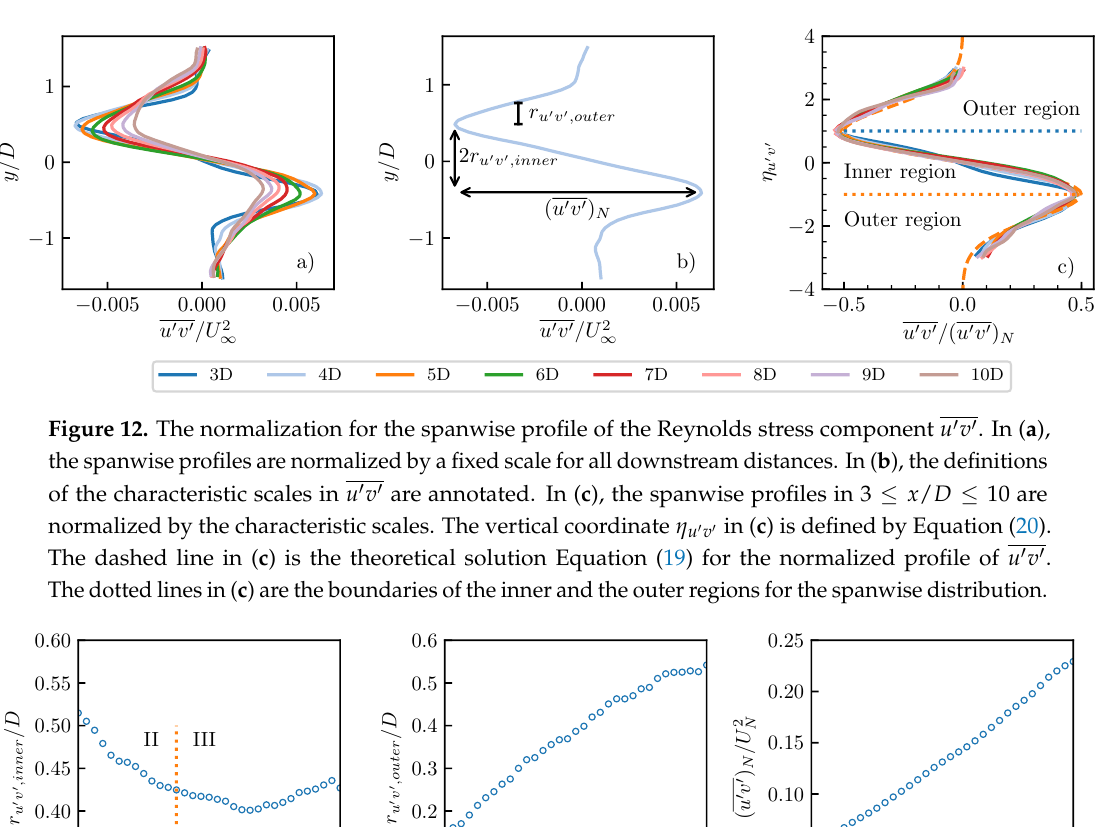
Figure 13. The streamwise development of the characteristic scales of the Reynolds stress component u (cid:48) v (cid:48) . The characteristic widths of the inner region and outer region are shown in ( a , b ), respectively, where the dotted line is the boundary of the stage II and III of the wake development. In ( c ), the characteristic Reynolds stress ( u (cid:48) v (cid:48) ) N is normalized by the characteristic velocity deficit